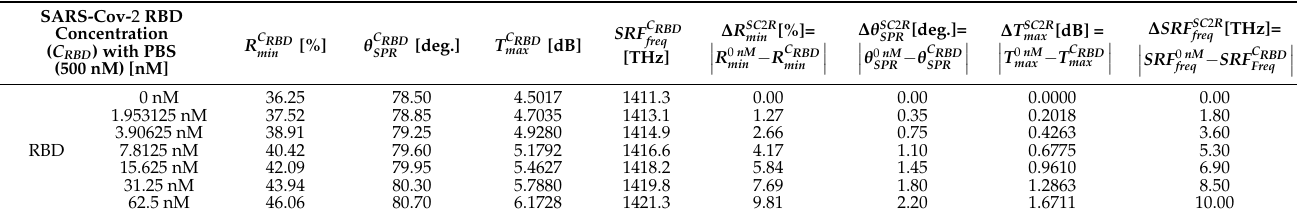
Table 5. ∆ R C RBD , θ C RBD , T C RBD max and SRF C RBD characteristics for different concentrations of SARS-Cov-2 Spike RBD as SPR min freq an analyte.